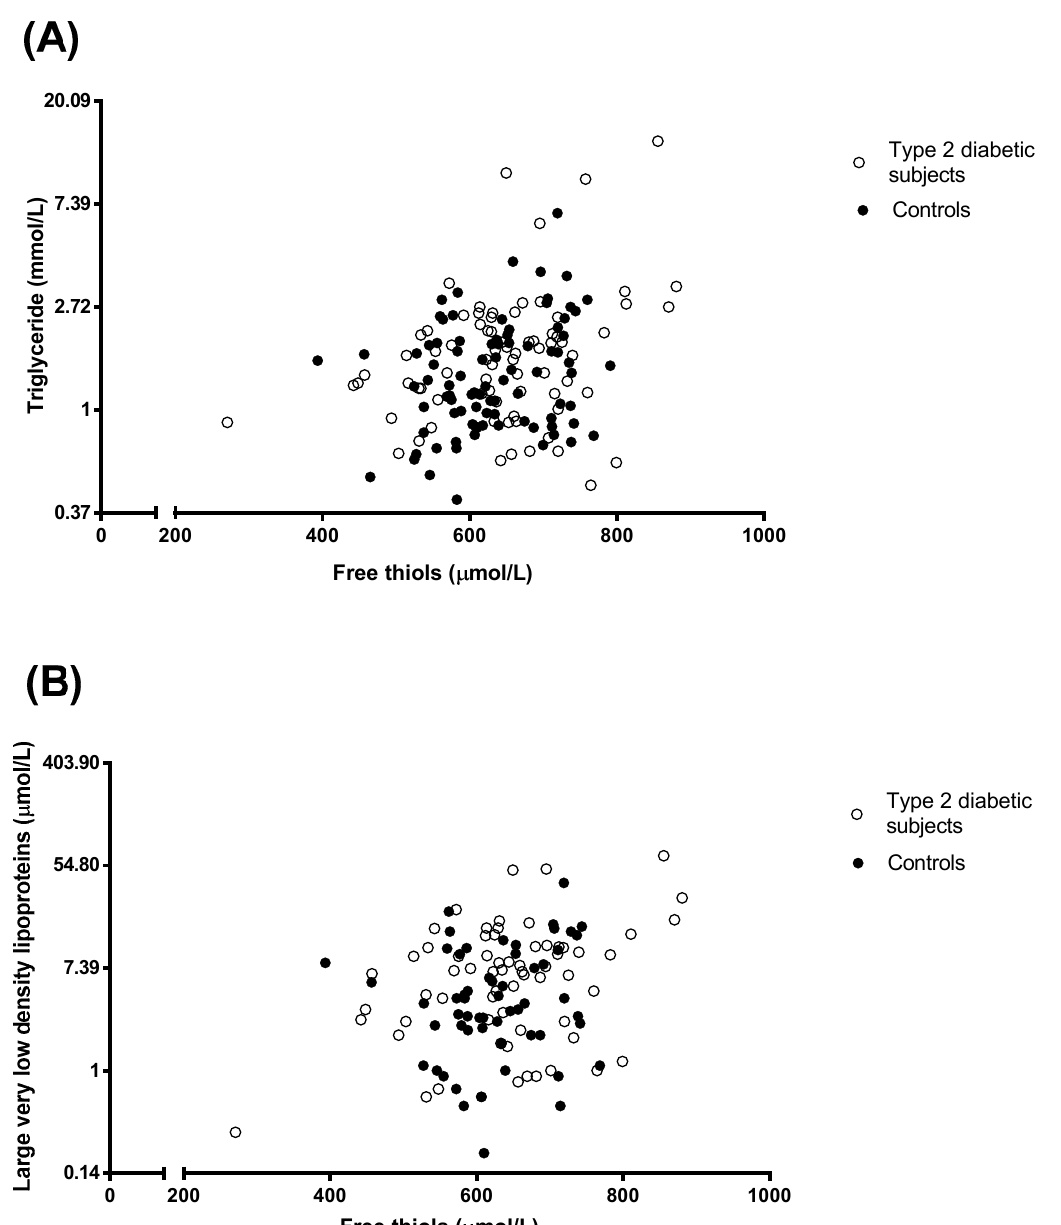
Figure 1. Univariate correlations of plasma free thiols with plasma triglycerides (panel A ; 79 type 2 diabetic subjects and 89 subjects without diabetes) and with very large very low density lipoprotein (VLDL) (panel B ; 66 type 2 diabetic subjects and 58 subjects without diabetes). Legend: closed symbols represent subjects without diabetes; open symbols represent subjects with type 2 diabetes. The log transformed data (i.e., triglyceride and large very low density lipoproteins) were used. The back transformed measures are shown on the Y -axis. Pearson correlation coefficients: free thiols with triglycerides; all subjects, r = 0.285, p < 0.001; Type 2 diabetic subjects, r = 0.290, p = 0.01; subjects without diabetes, r = 0.260, p = 0.014. Free thiols with large VLDL: all subjects, r = 0.266, p = 0.003; Type 2 diabetic subjects, r = 0.333, p = 0.006; subjects without diabetes, r = 0.138, p = 0.31. In all men combined (n = 98), plasma free thiols were inversely correlated with age and adiponectin, and positively with HOMA-IR, e-GFR, triglycerides, VLDL particle concentration and large VLDL particles (Table S1). In all women combined (n = 70), plasma free thiols were not significantly correlated with any of the variables listed in Table 2 (Table